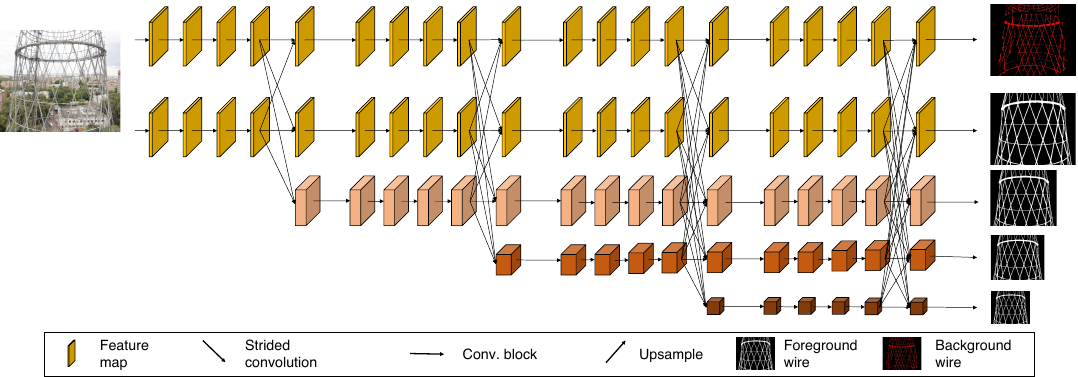
Figure 3. Overview of the WireNet model.